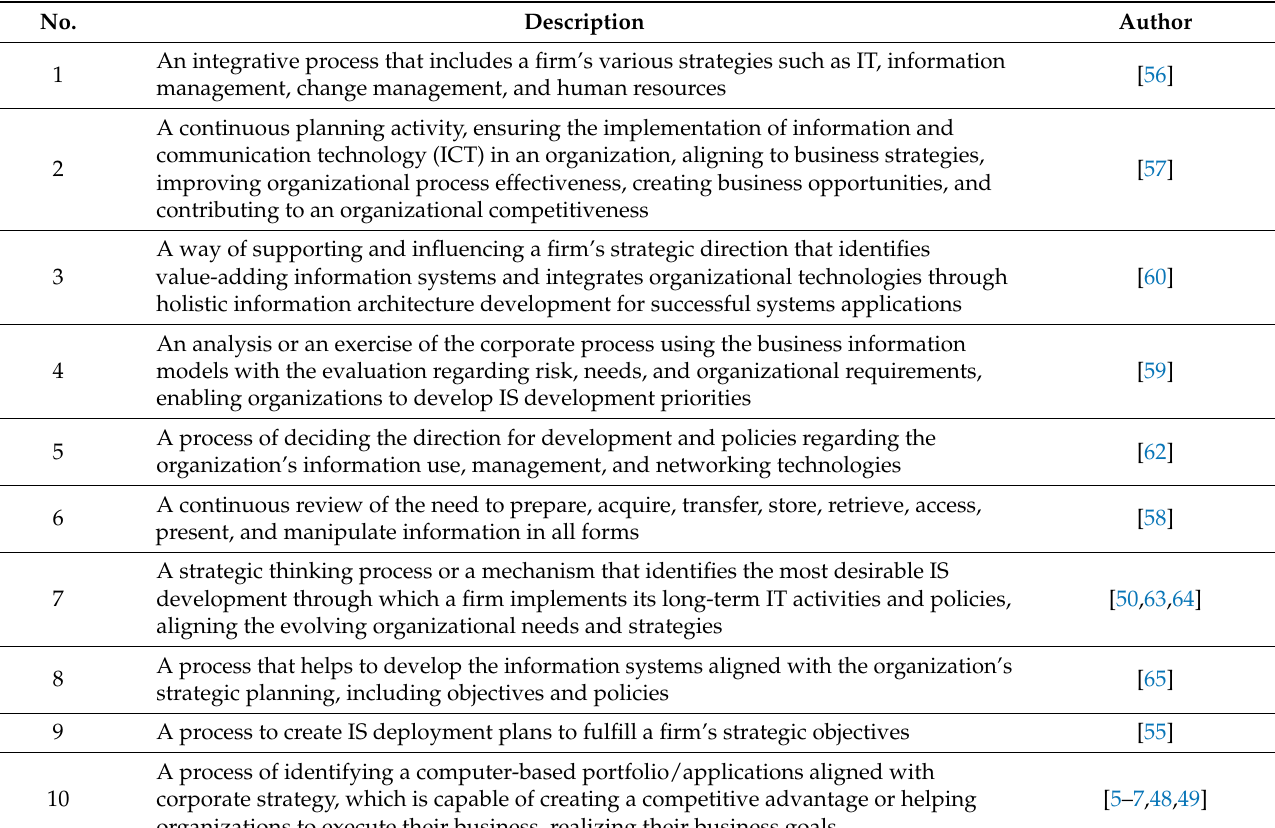
Table 1. SISP definitions in the